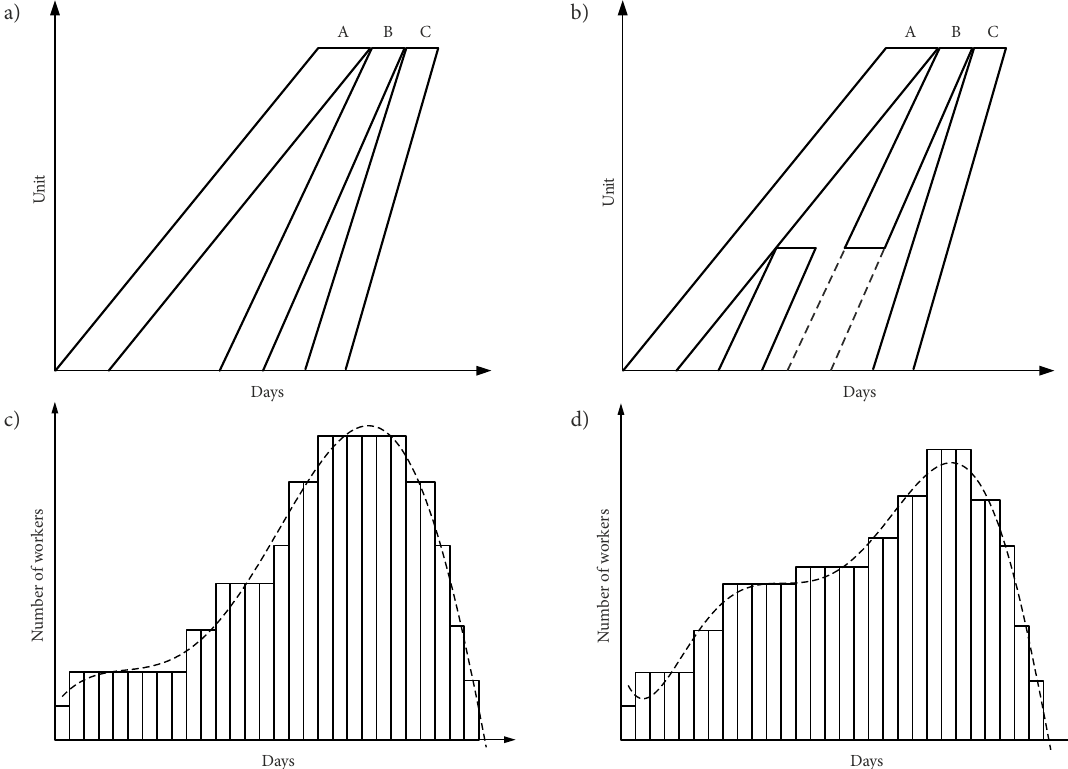
interruptionFigure 5. The first case: a – initial LOB schedule; b – LOB schedule with an interruption; c – resource usage curve of the initial LOB schedule; d – resource usage curve of the LOB schedule with an